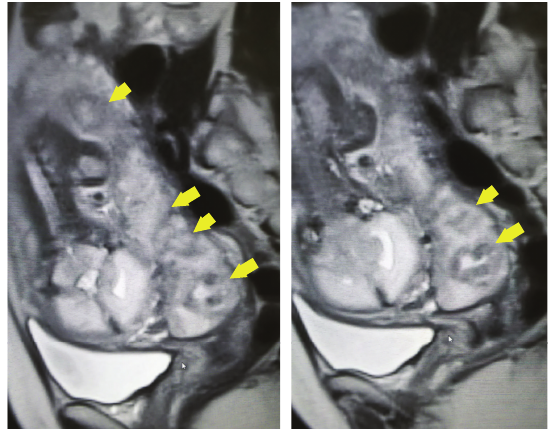
Figure 3: T2-weighted image showed a mixture of hyperintense and hypointense lesions (arrows) in the placenta, representing cotyledon